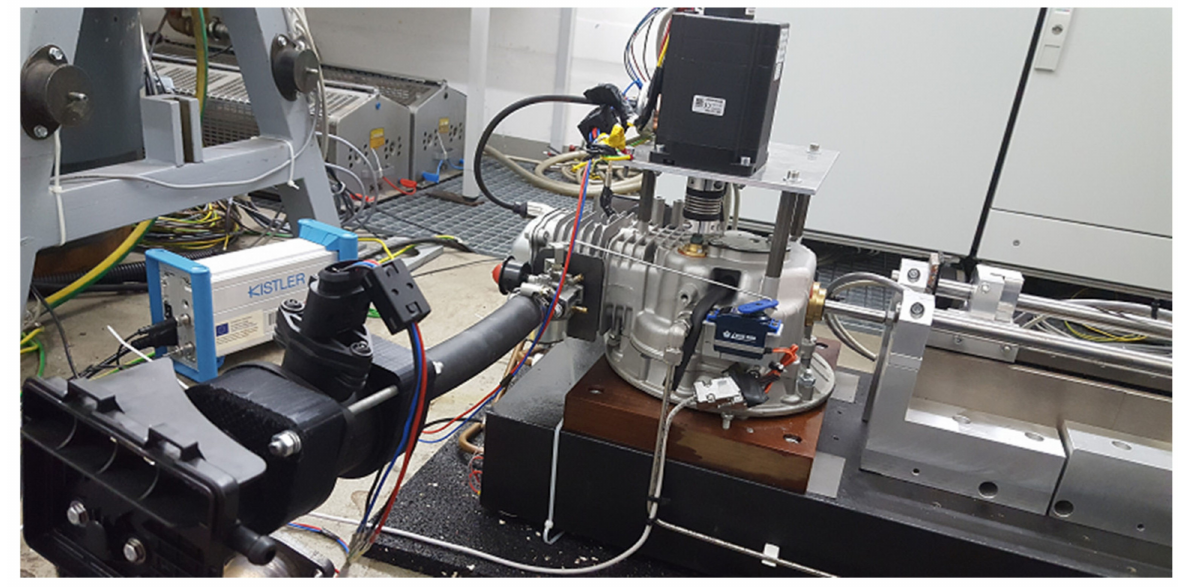
Figure 1. Experimental Prototype of the free-piston engine.